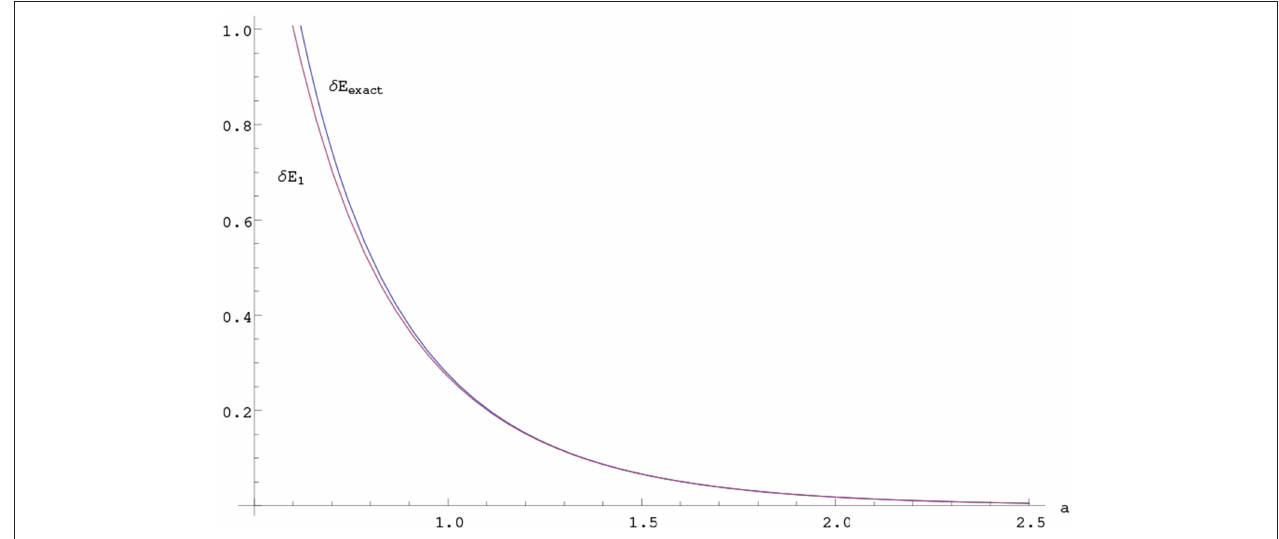
FIGURE 4 | Exact and first order perturbation results for the splitting in the energy as a function of a for µ